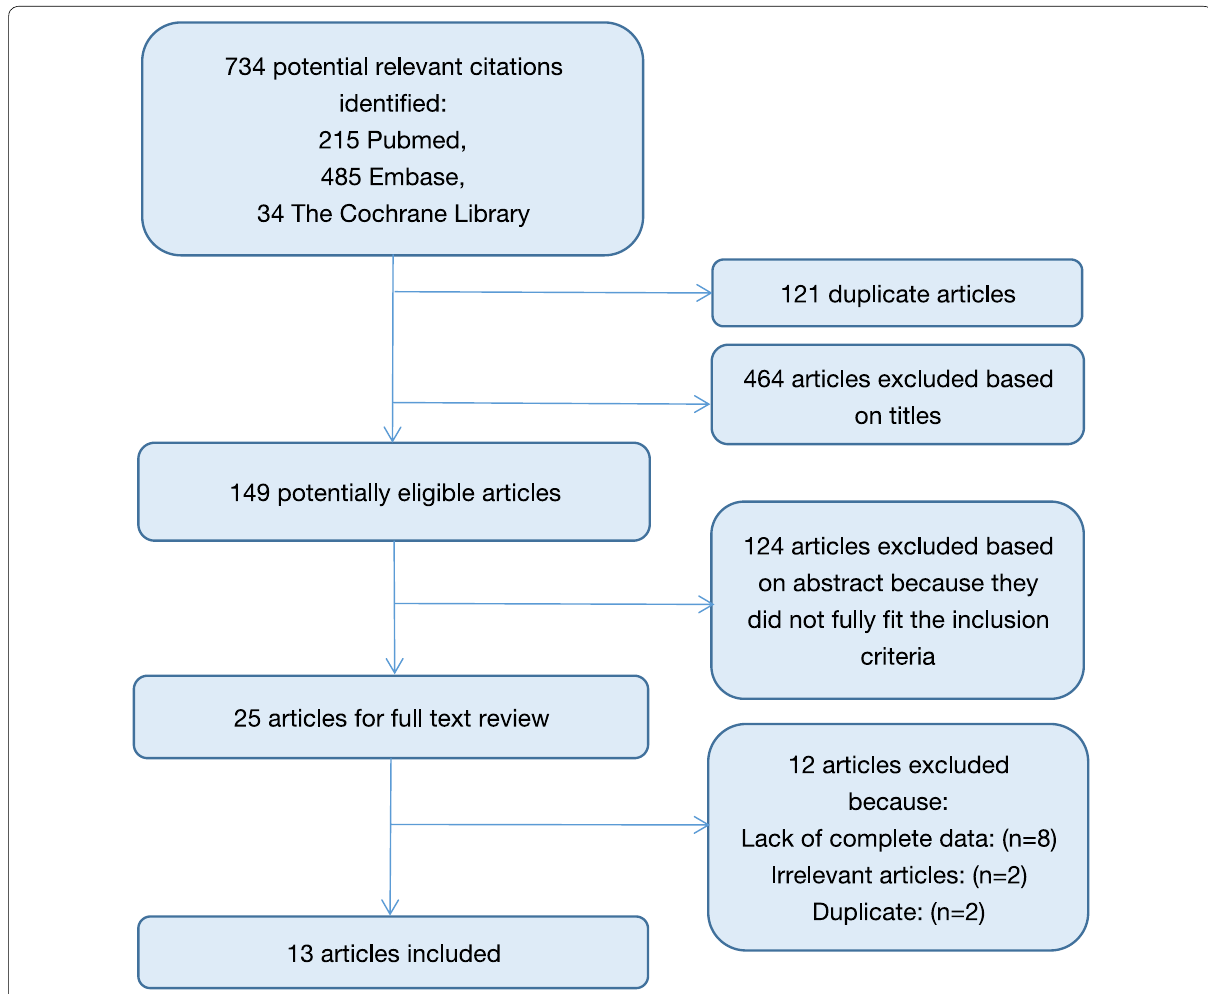
Fig. 1 Flow diagram showing the selection of articles included in this